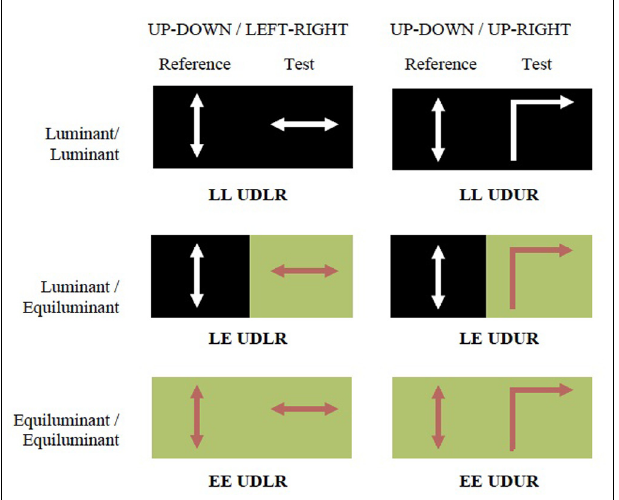
FIGURE 2 |The experiment consisted of six conditions. The two motion settings were up–down against left–right (UDLR) or up-right (UDUR).The two luminance settings were equiluminant (red dots moving against equiluminant green background) and luminance (white dots moving against black background).The average luminosities of each half of the screen were roughly equal.The six conditions are abbreviated as LL UDLR, LE UDLR, EE UDLR, LL UDUR, LE UDUR, and EE